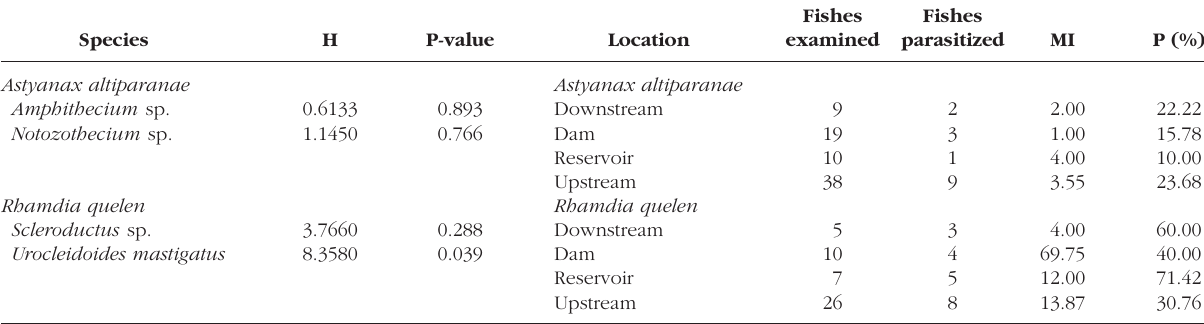
Table II. – Kruskal-Wallis (H) test comparing parasitism levels for each parasite species among sampling locations, and mean intensity (MI) and prevalence (P) of infestation in Astyanax altiparanae and Rhamdia quelen at each sampling